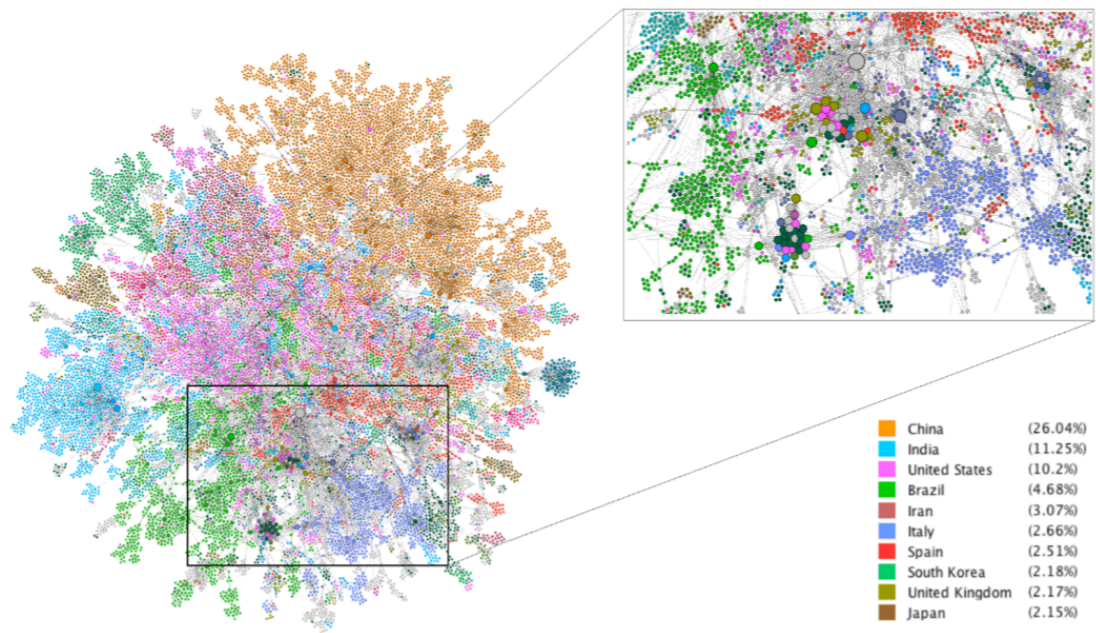
Figure 7. Collaborations in power quality by